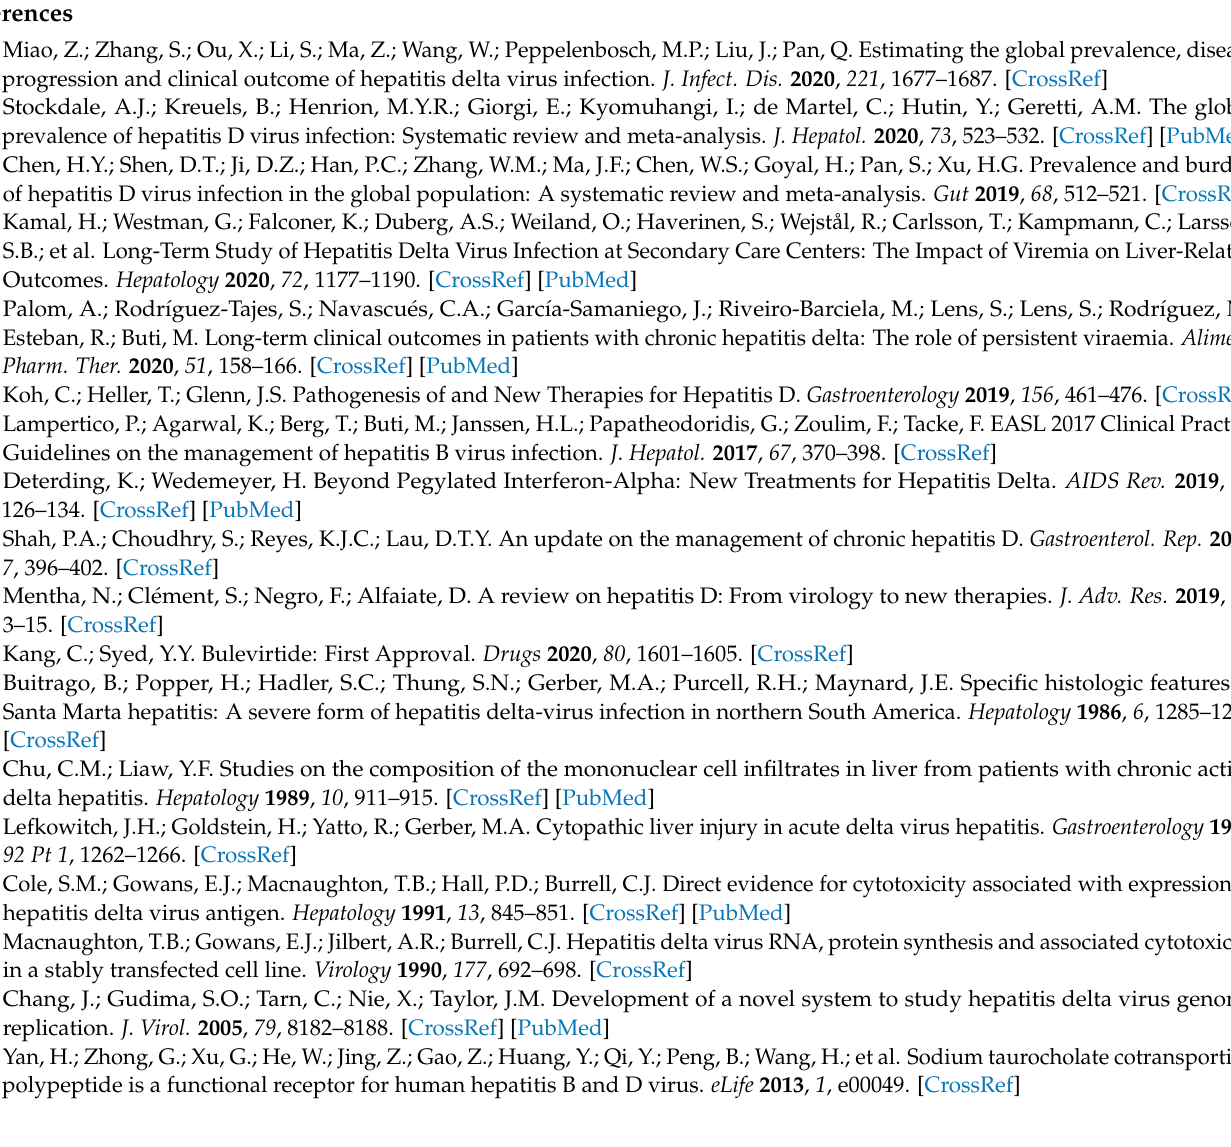
Figure A3. HDV genome copies increase with time in C57BL/6 mice after AAV-HDV WT or AAV-HDV- ∆ L-HDAg injection while the AAV genomes drop during the experiment. ( A ) HDV RNA was analyzed in livers of mice injected with AAV-HDV WT and AAV-HDV- ∆ L-HDAg by RT-qPCR. ( B ) Total DNA was extracted from infected livers and AAV-HDV genomes were quantified by qPCR. Statistical analysis by two-way ANOVA showed significant differences in HDV RNA at 14 dpi. * p < 0.05.